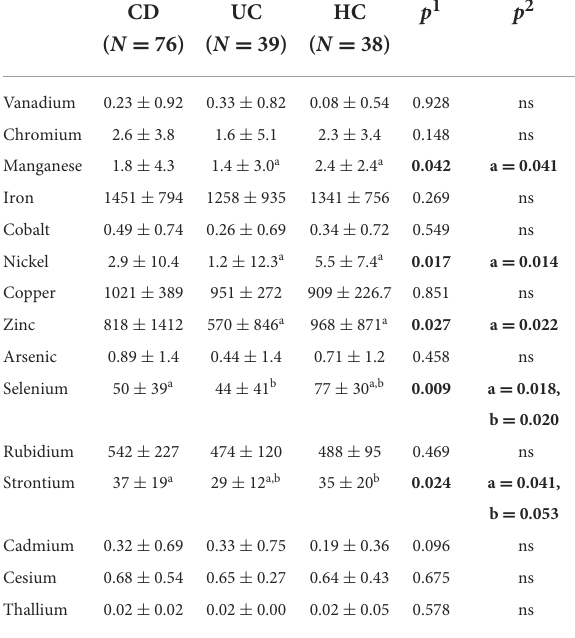
TABLE 2 Levels of trace metals ( µ g/L) in the plasma of CD, UC patients and